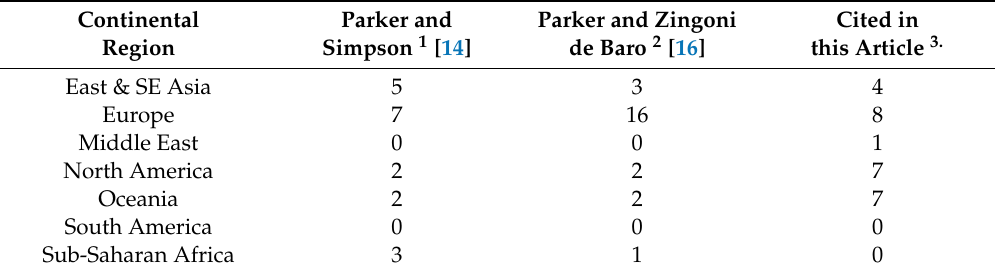
Table A2. Number of countries represented in the case studies and sources of data that informed this article.